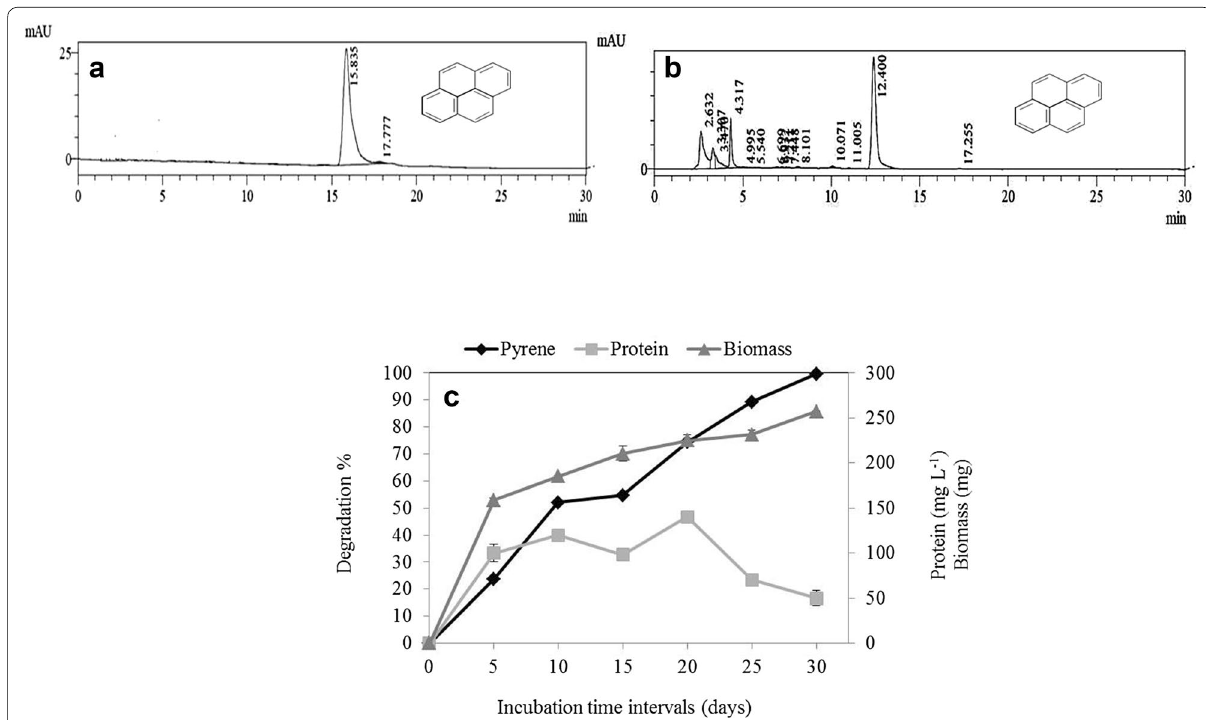
Fig. 3 Pyrene degradation by fungal strain CCG1. HPLC chromatogram of pyrene before ( a ) and after ( b ) treatment by fungi. c Degradation of pyrene and production of biomass, protein by CCG1 fungal